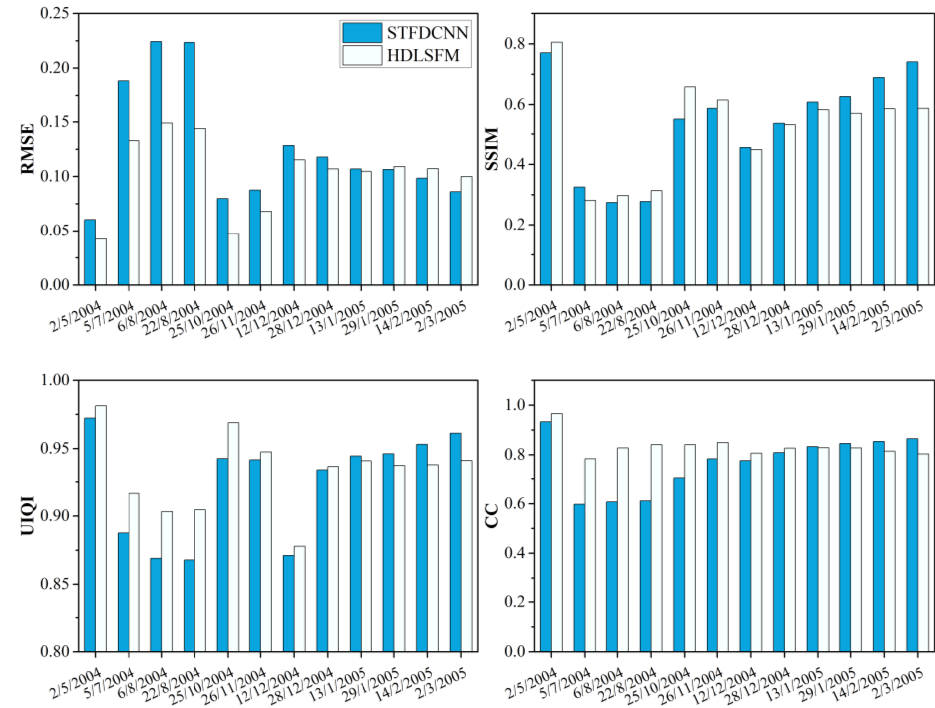
Figure 16. Quantitative assessment of the prediction results of STFDCNN and HDLSFM for the LGC site.